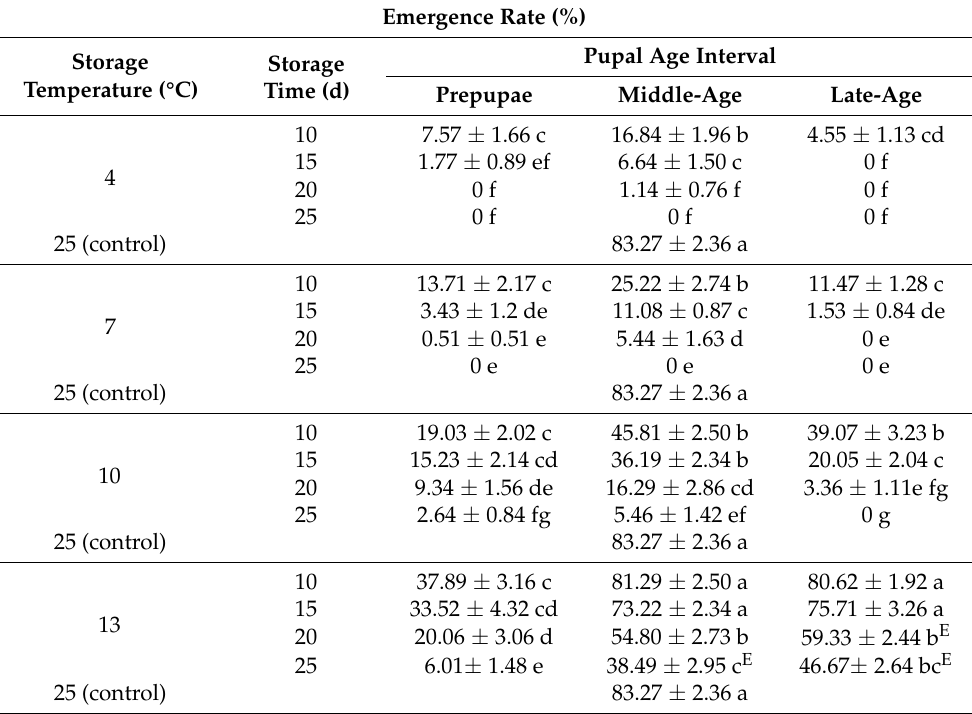
Table 1. Emergence rate of P. incisi after being subjected to different pupal cold storage treatments ( n =